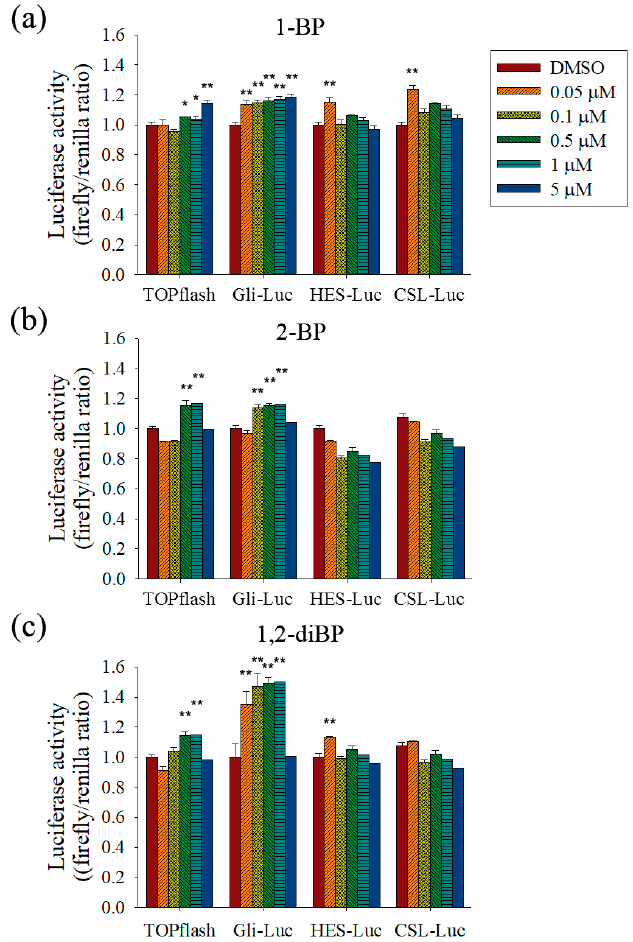
Figure 5. The effects of BP compounds on the activities of promoters related to Hedgehog, Notch, and Wnt signaling. HEK293T cells were co-transfected with the pRL-TK (renilla) plasmid and the pTOPflash, pGli-luc, pHES-luc, or pCSL-luc reporter plasmid (firefly). After 24 h, transfected cells were treated with various concentrations of 1-BP ( a ), 2-BP ( b ), or 1,2-diBP ( c ) and incubated for an additional 48 h. Cells were lysed, and firefly and renilla luciferase activity was measured. The firefly luciferase activity of each group was calculated, using the renilla luciferase activity as an internal control. The relative firefly luciferase activity of each BP compound compared with the untreated control group is shown. Data represent the mean ± SEM, and were analyzed by one-way ANOVA. * p < 0.05, ** p < 0.01, and *** p < 0.001 vs. the untreated control groups for each BP compound.